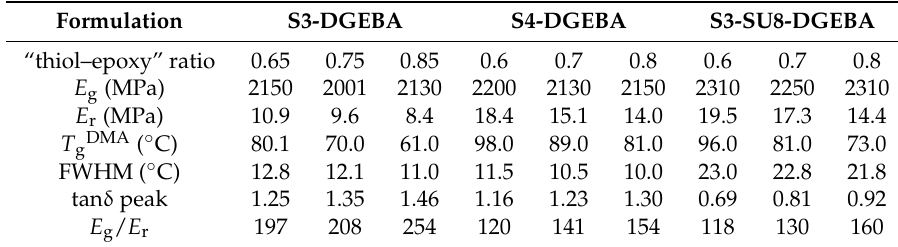
Table 3. Thermomechanical and structural properties of the different formulations of study.